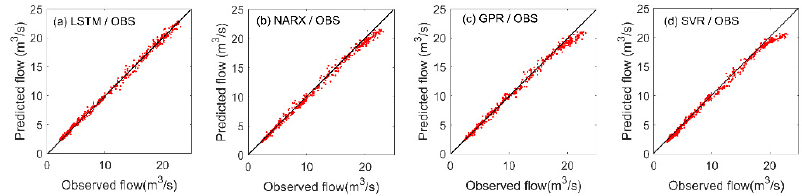
Figure 7. Boxplot of residuals.